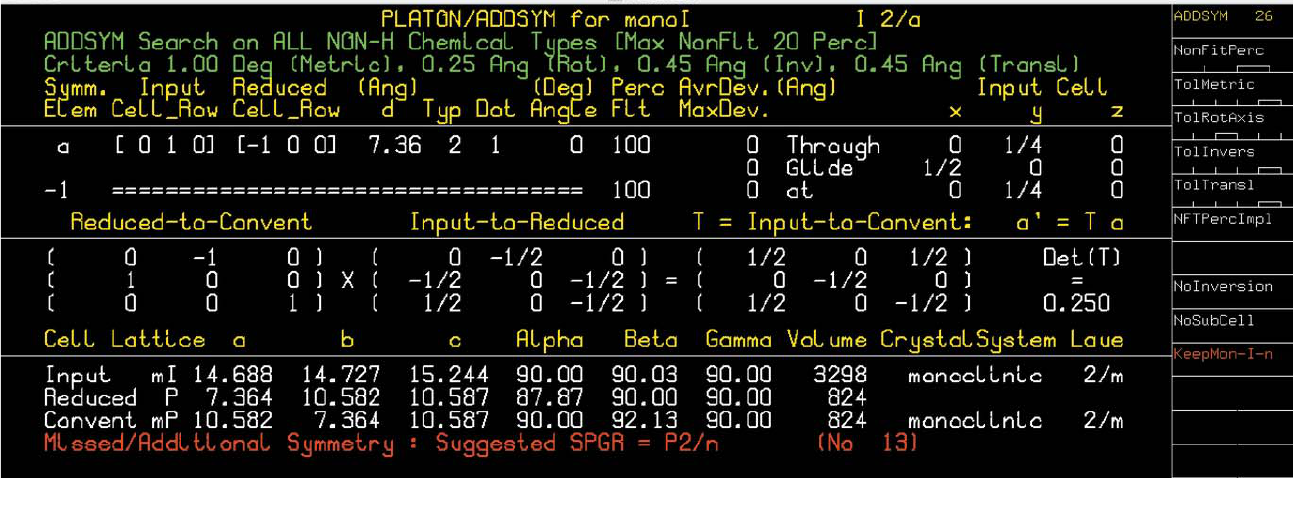
Figure 12 A search for missed symmetry using ADDSYM in PLATON (Spek, 2020) reveals that the symmetry of untwinned individuals in SAXDUR is actually P 2/ n rather than I 2/ a . Thus, the true asymmetric unit contains only half as many atoms as in the I 2/ a